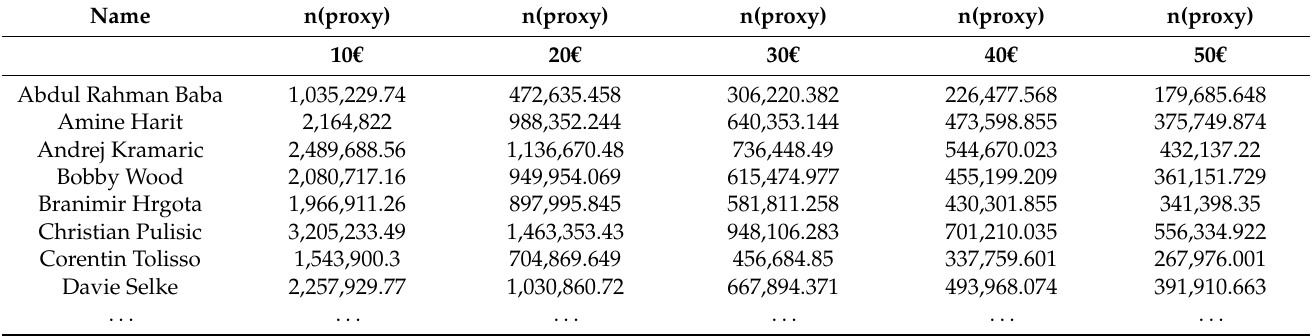
Table 4. Calculation of the expected number of customers depending on the profit margin (extract from the database of the first eight players—( p j − c )).